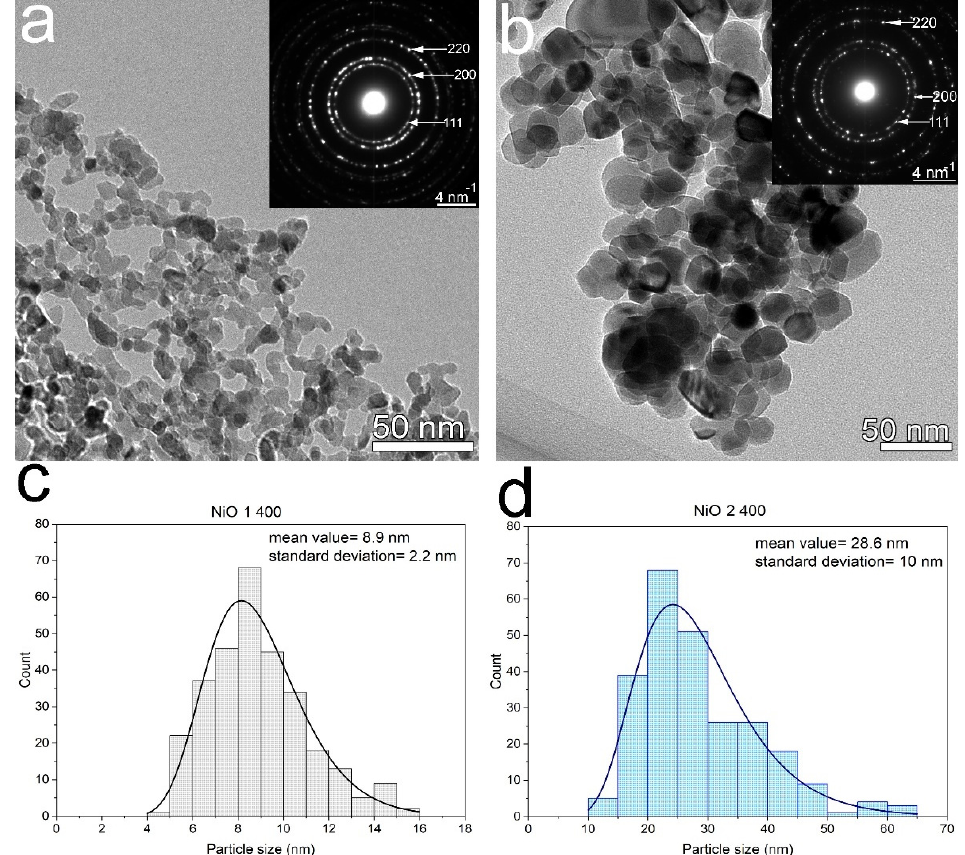
Figure 3. TEM images and corresponding SAED patterns (inset) of ( a ) NiO1 400 and ( b ) NiO2 400, and the size histograms obtained after measuring 250–300 nanoparticles from low-magnification TEM images along with the log-normal fitting for ( c ) NiO1 400 and ( d ) NiO2 400.